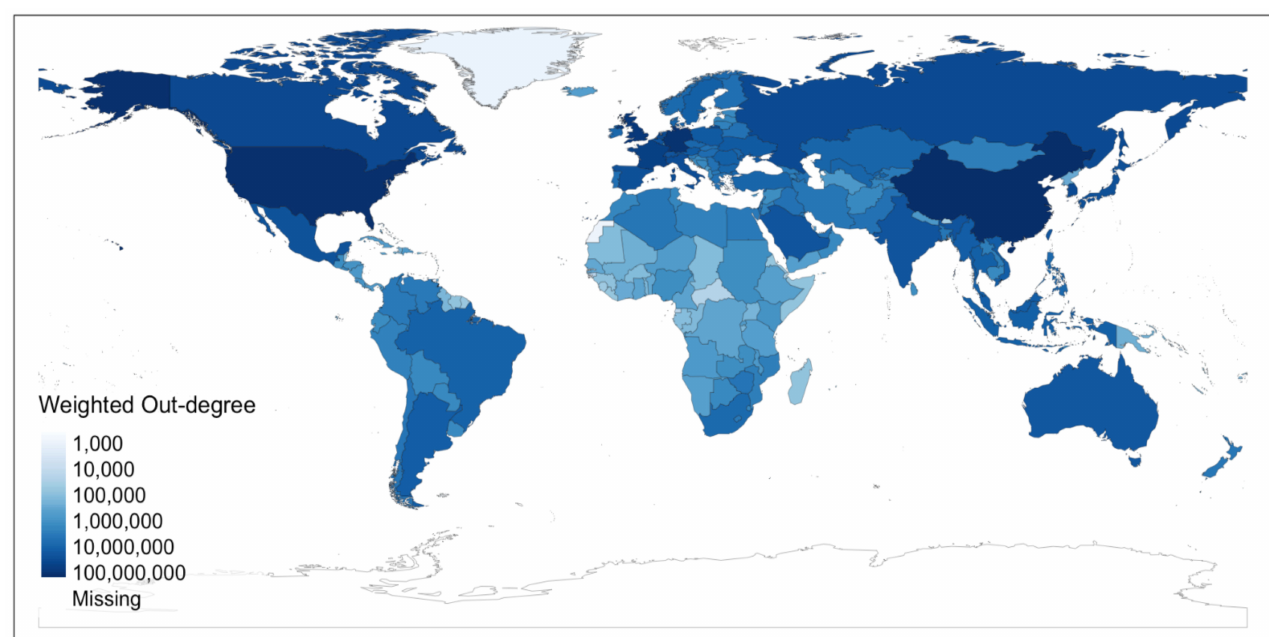
Figure 5. Weighted out-degrees. Source: